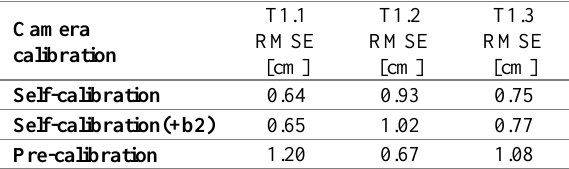
Table 2 – Statistics of the differences on the check points using